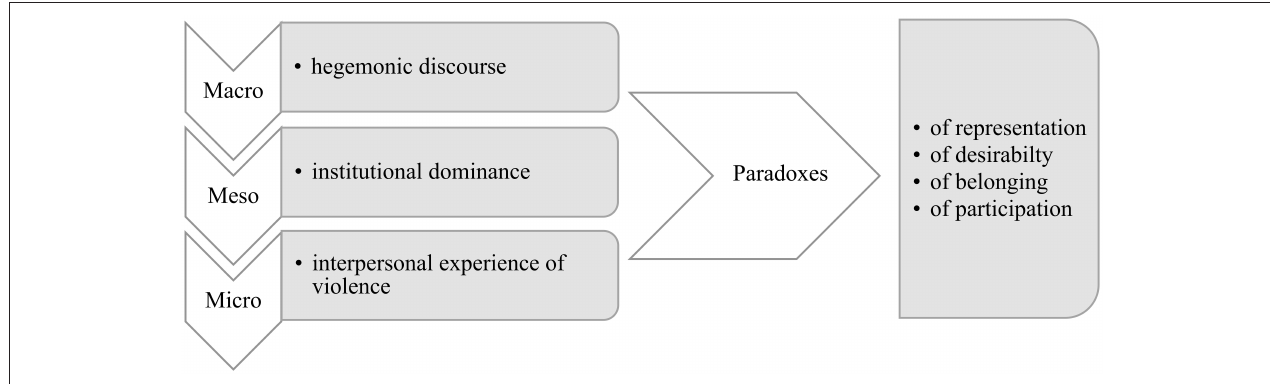
FIGURE 1 | Three themes regarding how hegemonic challenges manifest themselves on all societal levels, including the paradoxes they create for queer refugees.